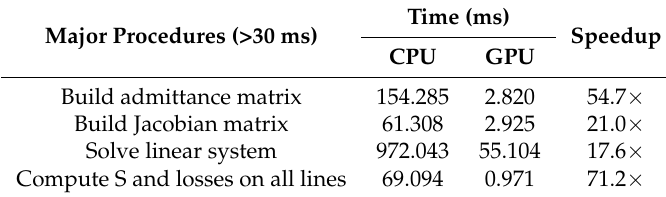
Table 1. Implementation of the NR method with average time and speedup in [49].